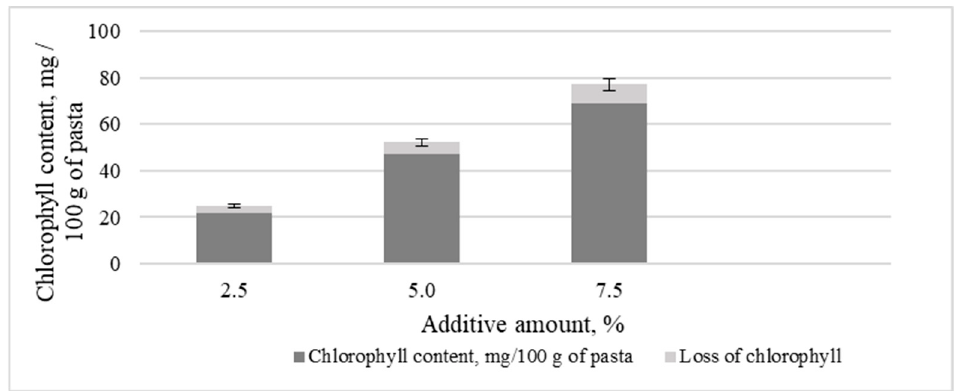
Figure 3. The content of chlorophyll in finished pasta, taking into account its losses during cooking . It was found that the total loss of chlorophyll during pasta cooking is about 10%.